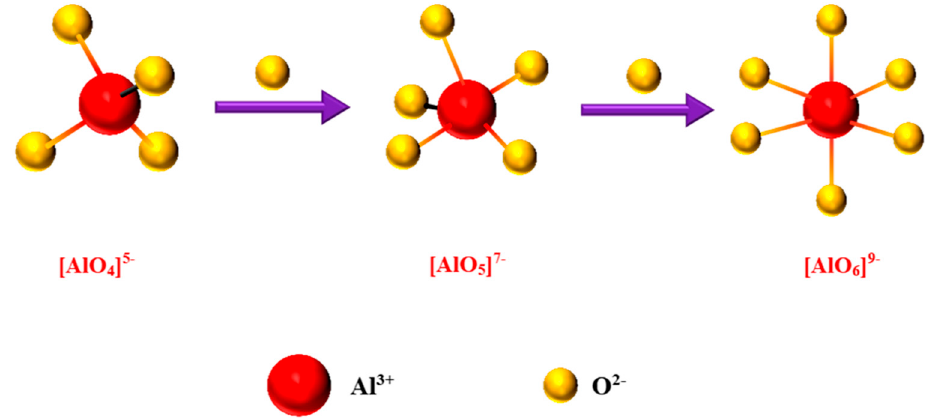
Figure 14. Aluminumo xygen polymer microstructural evolution of the BF smelting slag.